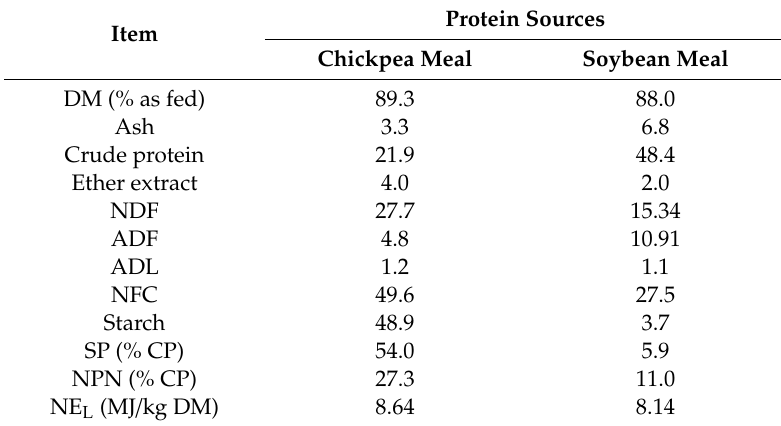
Table 1. Chickpea and soybean meal nutritive value characteristics (% of dry matter, DM, if not otherwise